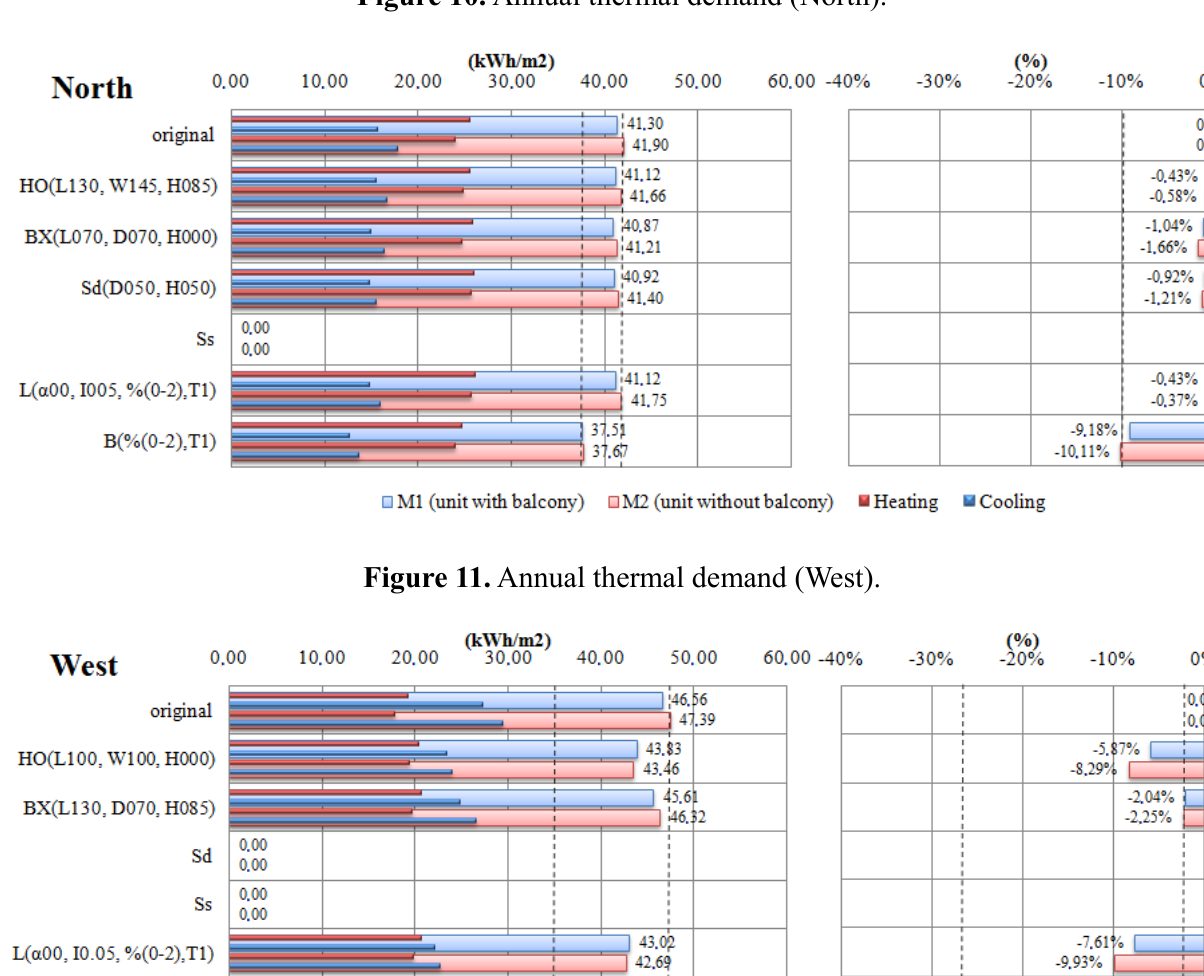
Figure 10. Annual thermal demand (North).